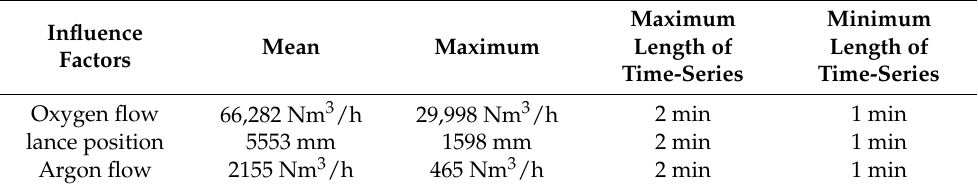
Table 2. Statistical results of the influencing factors of the time-series type.